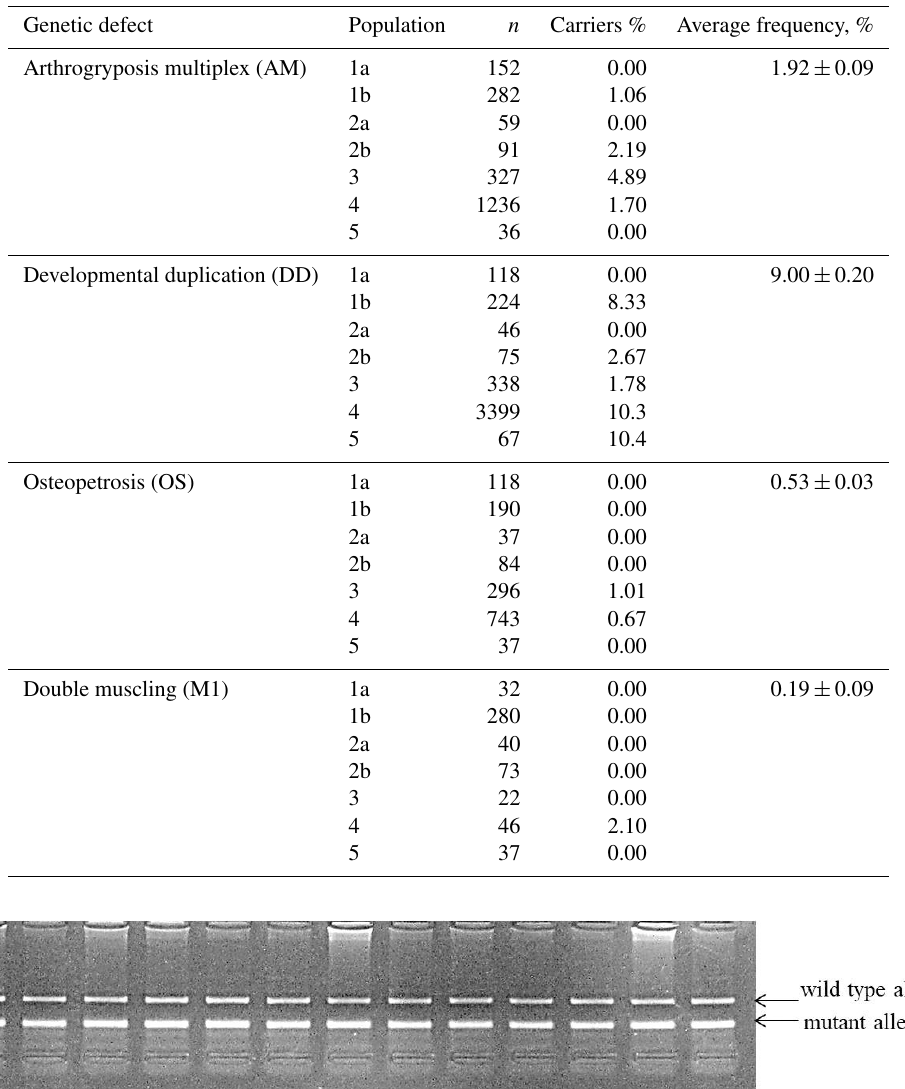
Table 3. The frequencies of animal carriers of the genetic defects of AM, DD, OS and M1 in the Russian Aberdeen Angus populations. Genetic defect